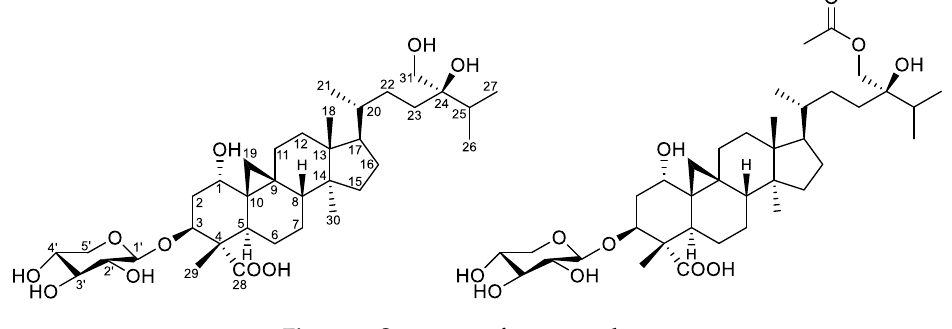
Figure 1. Structures of compounds 1 – 2 .